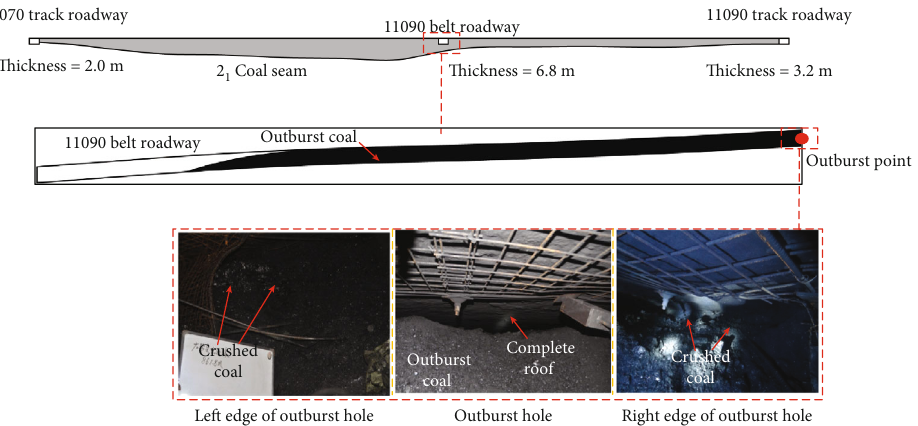
Figure 5: Field investigation features of outburst in the Xinyi Coal Mine.